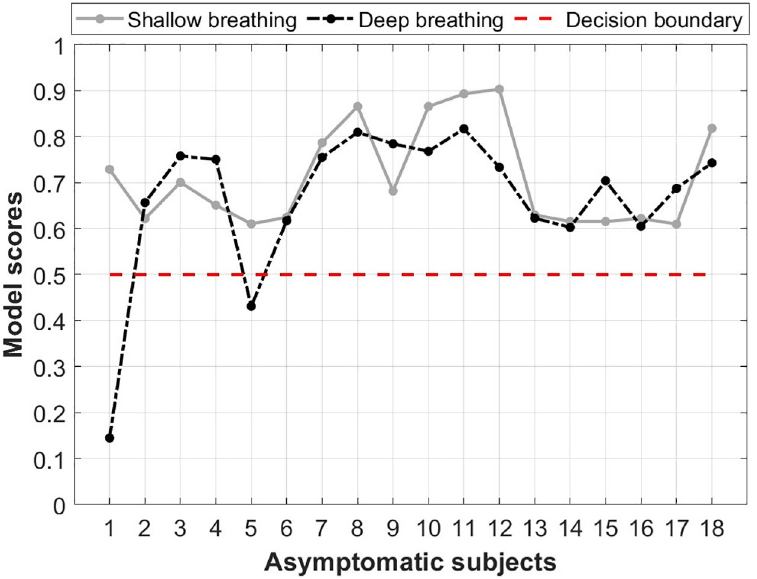
Fig 8. Asymptomatic COVID-19 subjects’ predictions based on the proposed deep learning model. The model had a decision boundary of 0.5 to discriminate between COVID-19 and healthy subjects. The values represent a normalized probability regrading the confidence in predicting these subjects as carrying